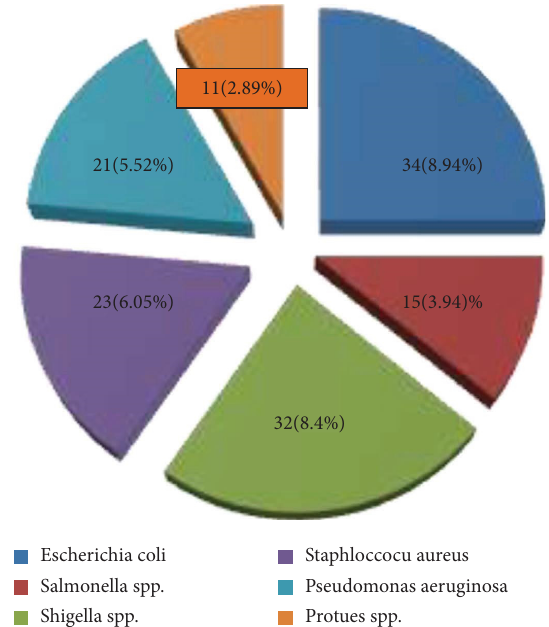
Figure 2: Overall prevalence of bacterial isolates from wastewater treatment